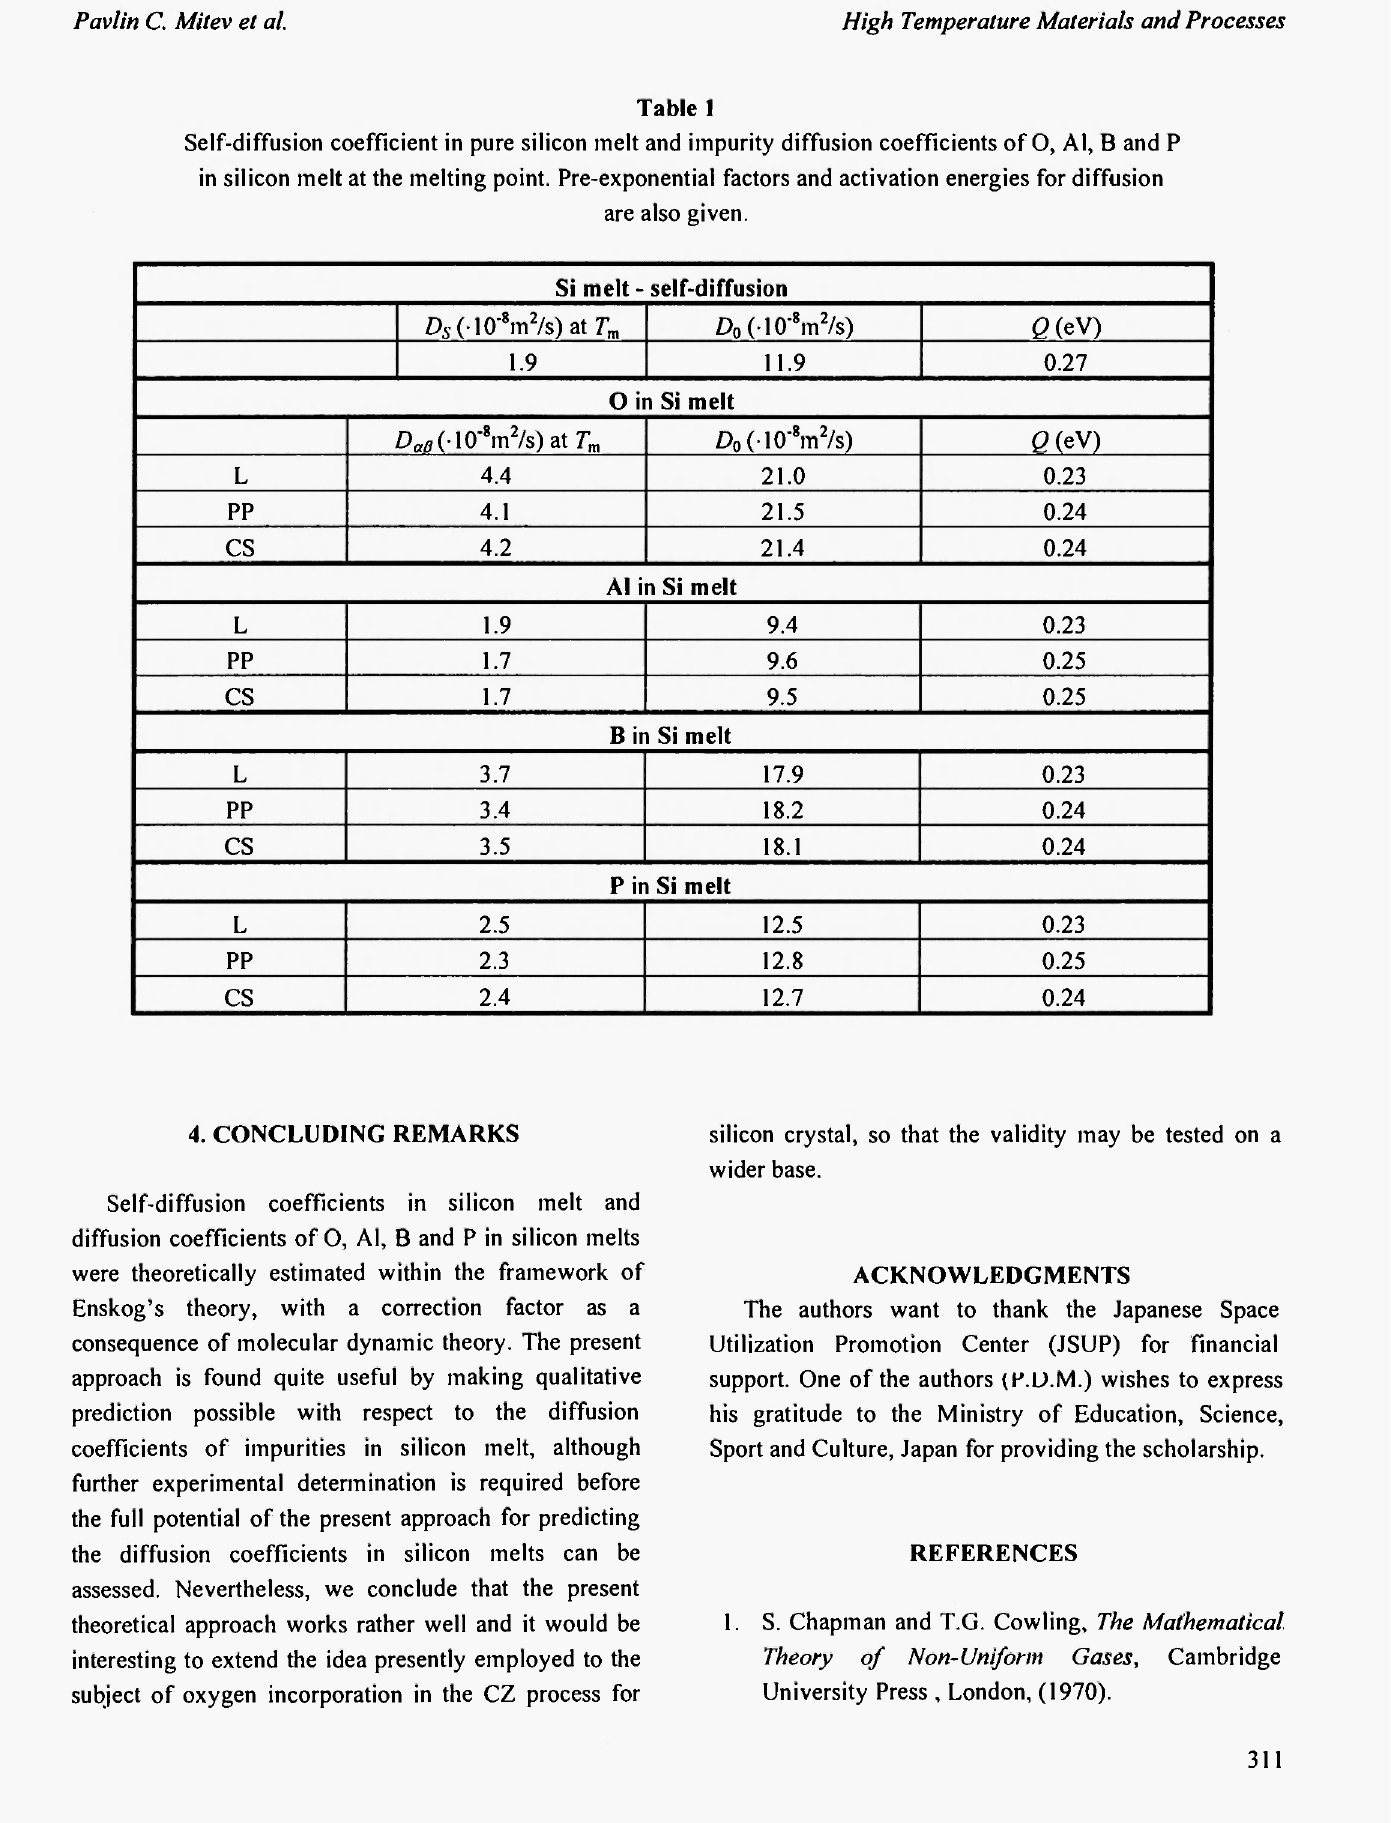
Self-diffusion coefficient in pure silicon melt and impurity diffusion coefficients of O, Al, Β and Ρ in silicon melt at the melting point. Pre-exponentiai factors and activation energies for diffusion are also